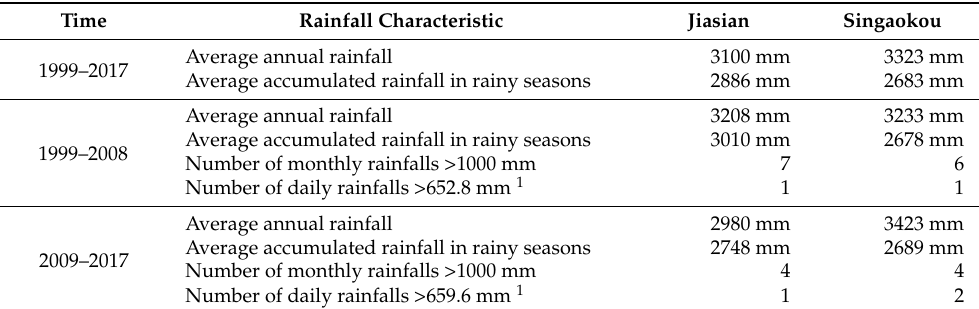
Figure 4. The distribution of monthly rainfall at the Jiasian (down plot) and Singaokou (middle plot) stations and the annual landslide number (blue line in upper plot) and area (red line in upper plot) during 1999–2017 in the Chishan river watershed. Table 3. The rainfall characteristics at the Jiasian and Singaokou rainfall stations in 1999–2017 in the Chishan river watershed.